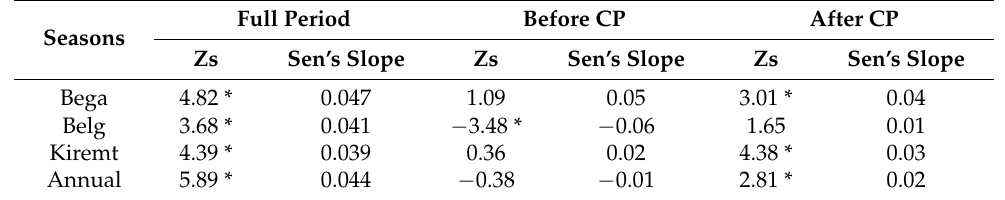
Table 5. The M–K test and Sen’s slope results of seasonal and annual mean temperatures before the changing point (1986–1993), after the changing point (1994–2015), and full study period (1986–2015). Full Period Before CP After CP Seasons Zs Sen’s Slope Zs Sen’s Slope Zs Sen’s Slope Bega 4.82 * 0.047 1.09 0.05